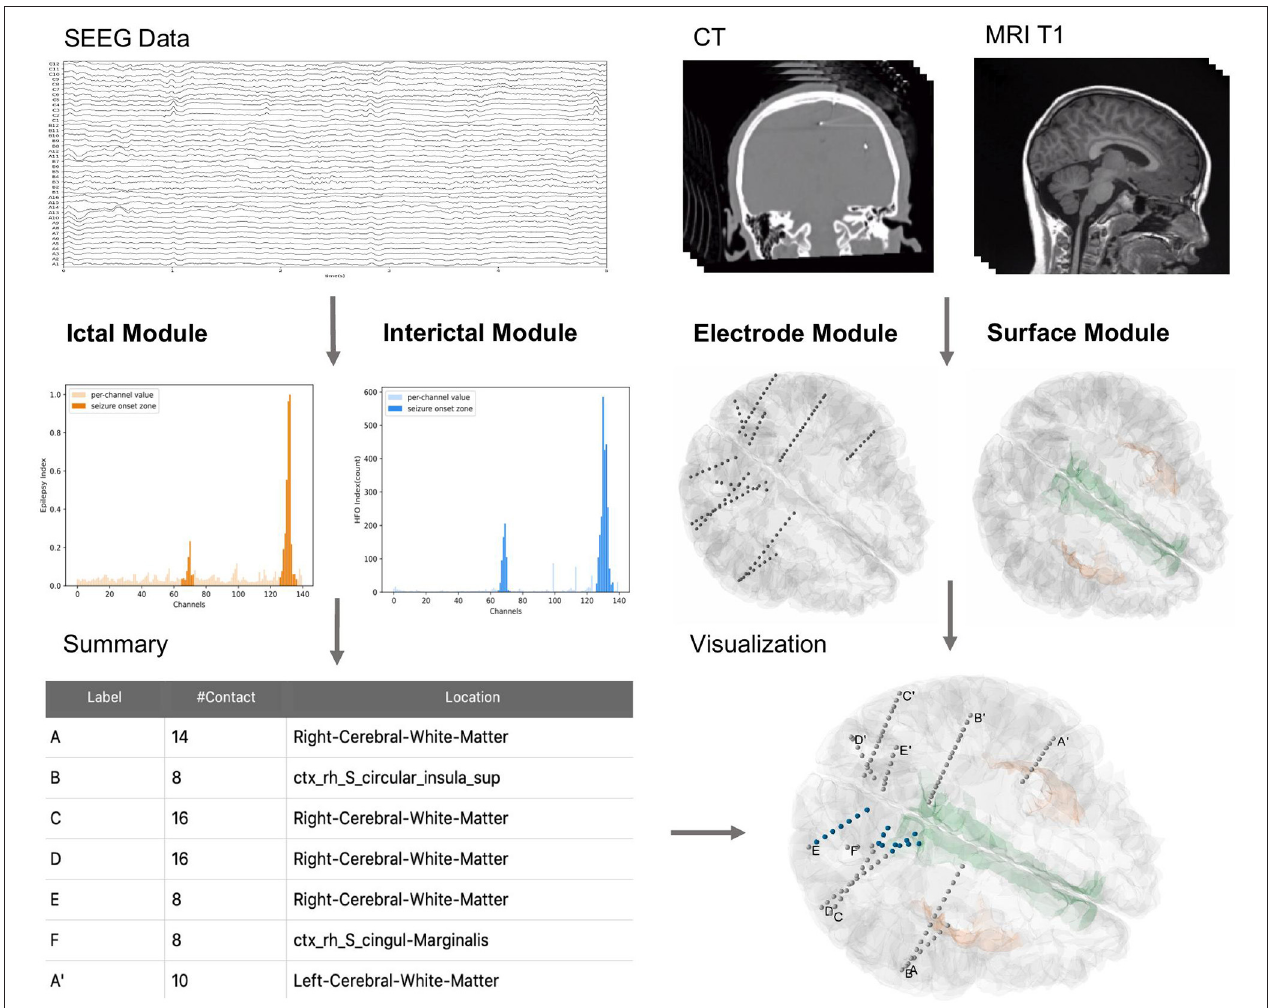
FIGURE 1 | General overview of BrainQuake structure. BrainQuake is designed to analyze the SEEG data (ictal and interictal), CT images, and MRI T1 images. Ictal and interictal modules are used to predict suspect contacts within seizure onset zones (SOZs). The electrode module exploits the graphic information from a CT image to locate the stereoelectroencephalography (SEEG) electrodes and contacts, as well as project them onto the brain surface, which is reconstructed by the surface module. The locations of suspect contacts are marked (blue) on the 3D plot of the surface and electrodes, giving a brief overview of the presurgical evaluation